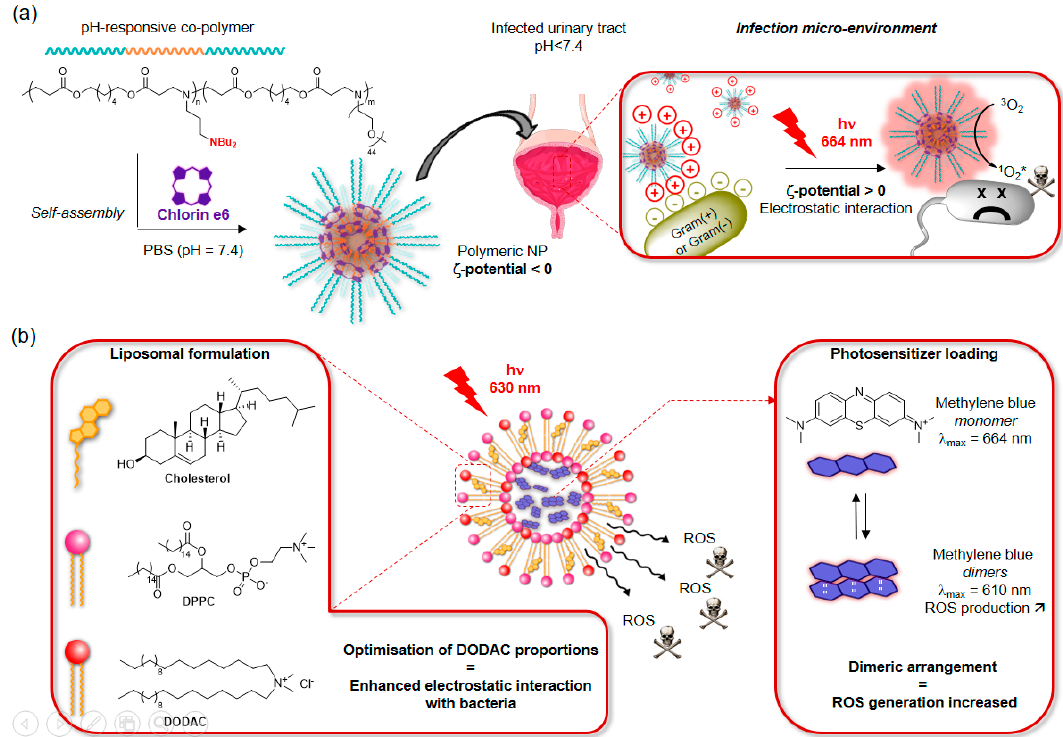
Figure 8. ( a ) Design of Ce6-containing pH-responsive polymeric nanoparticles for the treatment of bacterial infections in slightly acidic media such as the urinary tract [117]. ( b ) Example of liposomal formulation allowing both bacterial targeting via tuning of the surfactant proportions, and of the photosensitisation properties via MB loading